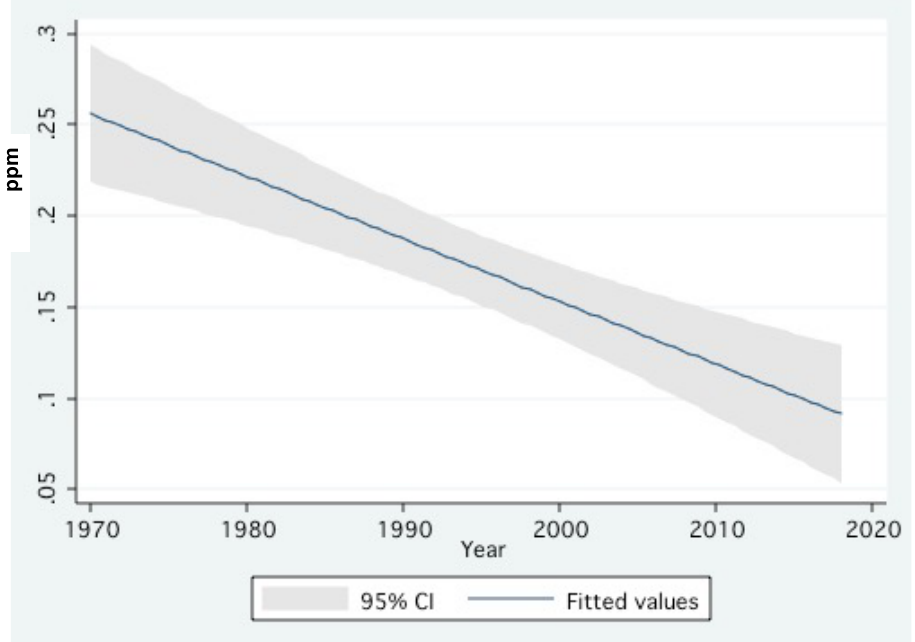
Figure 9. Temporal changes in climate conditions in the Kinneret watershed. Temporal (1970–2018) changes in annual concentrations of monthly mean TP concentrations (ppm) in the Jordan River (linear prediction (95%